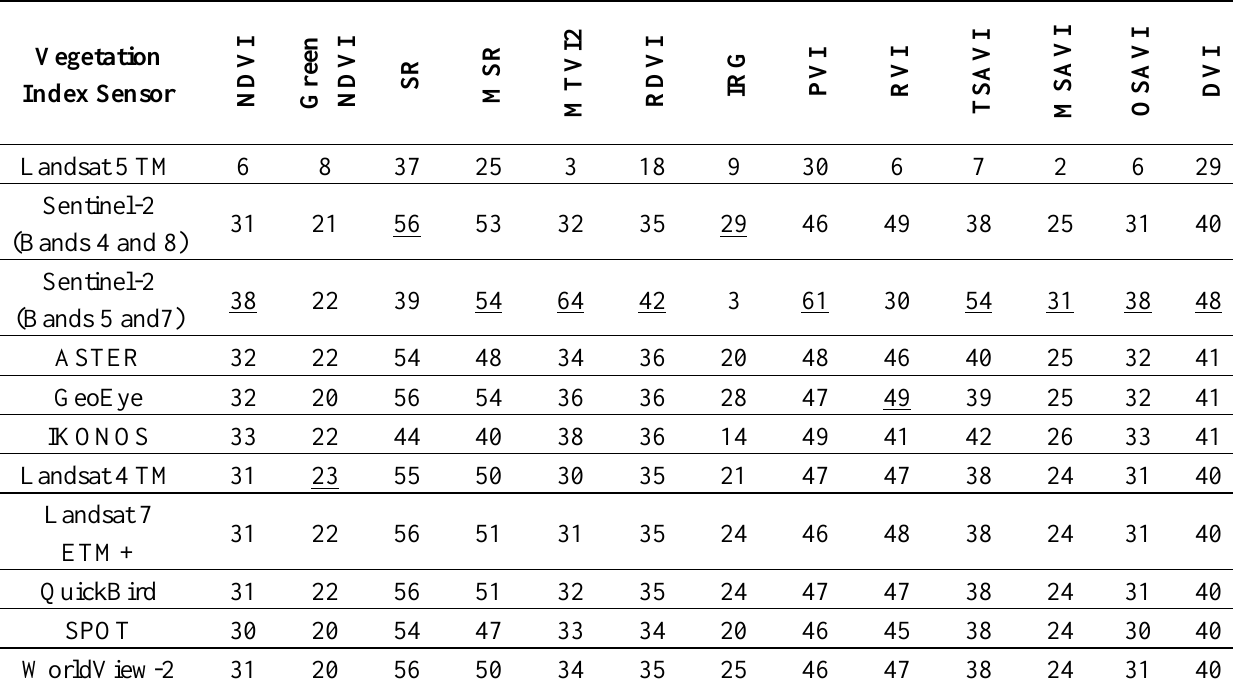
Table 3. Relative difference between ―vegetation marks‖ and the surrounding healthy vegetation using different vegetation indices. The maximum difference for each index is